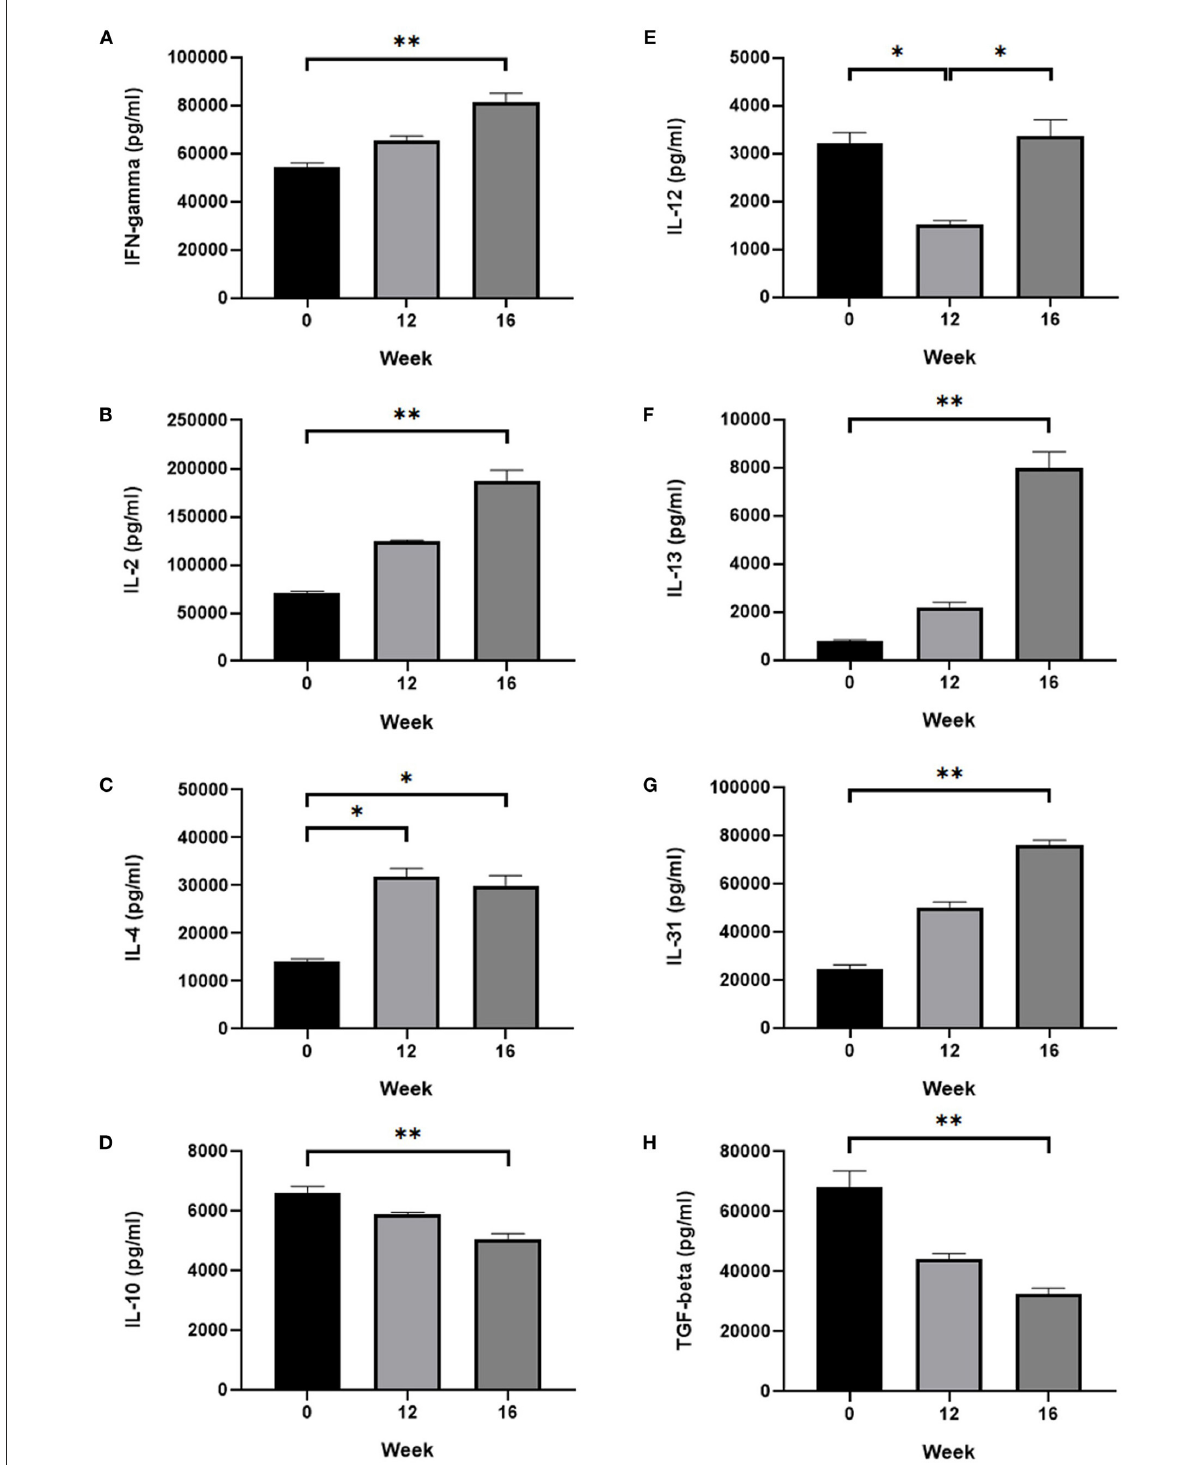
FIGURE7 Serum cytokine analysis. Change in the serum level of (A) IFN-gamma, (B) IL-2, (C) IL-4, (D) IL-10, (E) IL-12, (F) IL-13, (G) IL-31, and (H) TGF-beta. IL-4, IL-13 and IL-31, which belong to the Th2 cytokine group, were increased significantly after provocation. IFN-gamma, IL-2, and IL-12, which belong to the Th1 cytokine group, did not show a common pattern over the time course. IL-10 and TGF-beta, which belong to the Treg cytokine group, were decreased significantly after provocation. Zero week, pre-sensitization; 12 week, post-sensitization; 16 week, post-provocation. All values are expressed as the mean ± standard error. * P < 0.05, ** P <